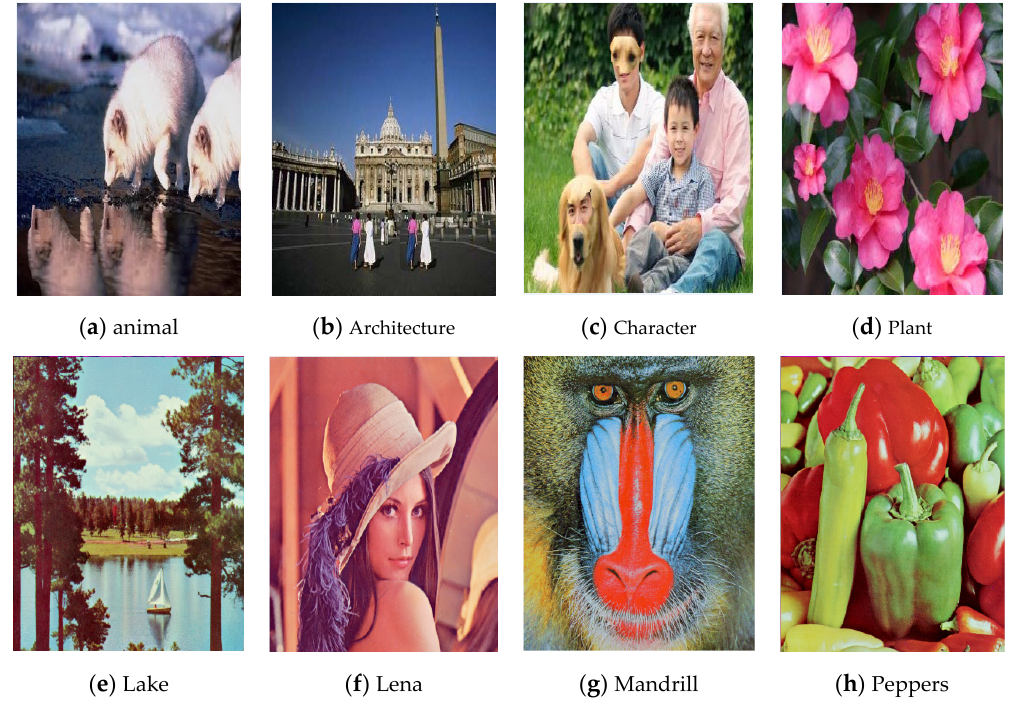
Figure 5. Example images: (1) CASIA V 1.0 dataset ( a – d ); (2) SIPI dataset ( e – h ).